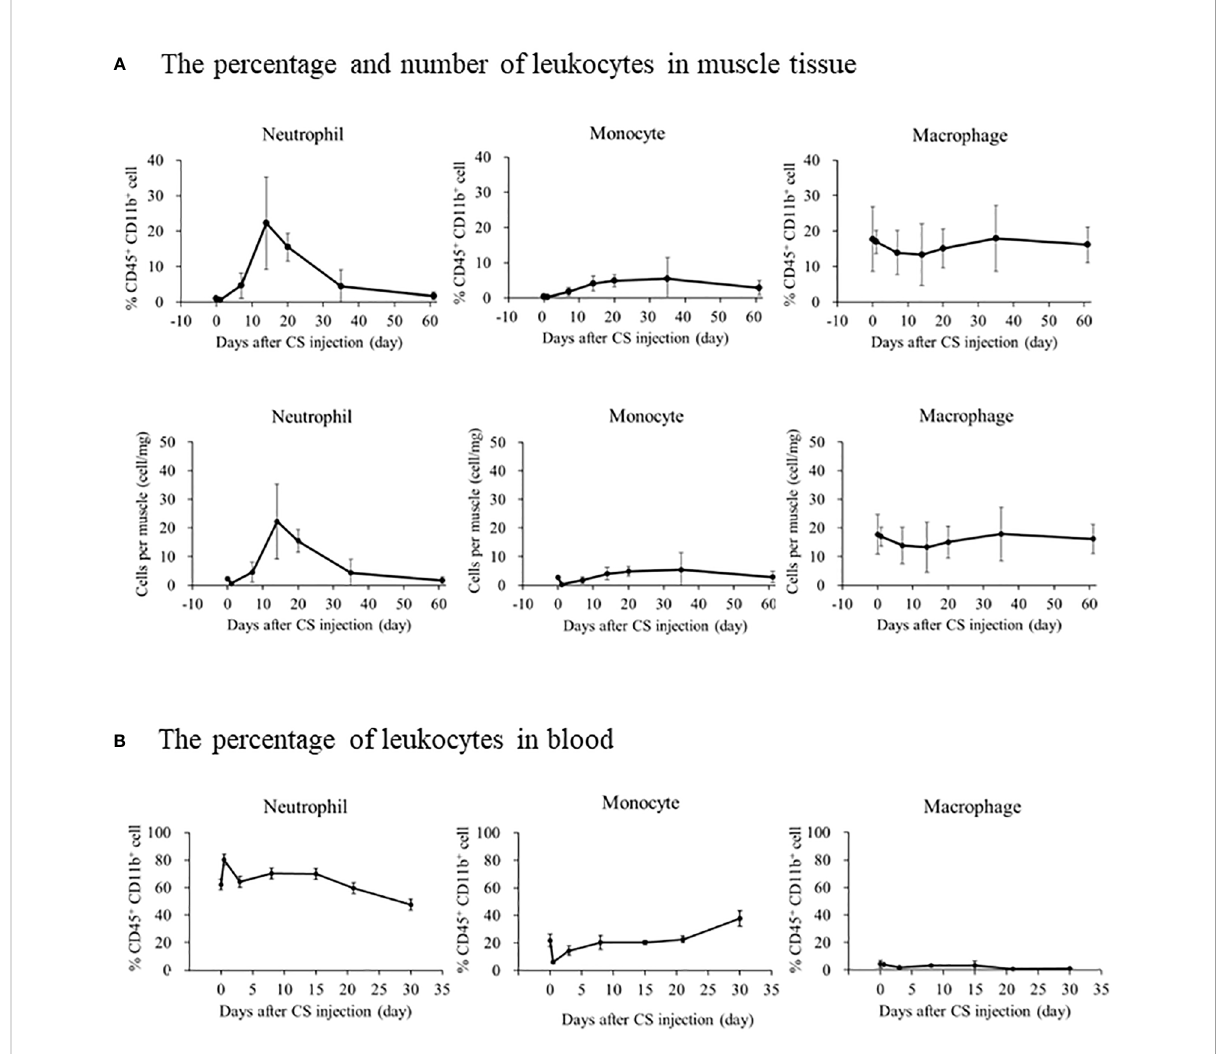
FIGURE 2 The longitudinal change in immune effector cells in muscle or blood after CS injection in mice. (A) The upper graph depicts the percentage change in immune effector cells in CD45 + CD11b + cells in the muscle, and the lower graph depicts the number of immune effector cells identi fi ed per muscle. Number of samples were Five CS and two control mice at each measurement day. (B) The percentage of immune effector cells in CD45 + CD11b + cells in the blood. Number of samples were three CS and one control mice at each measurement